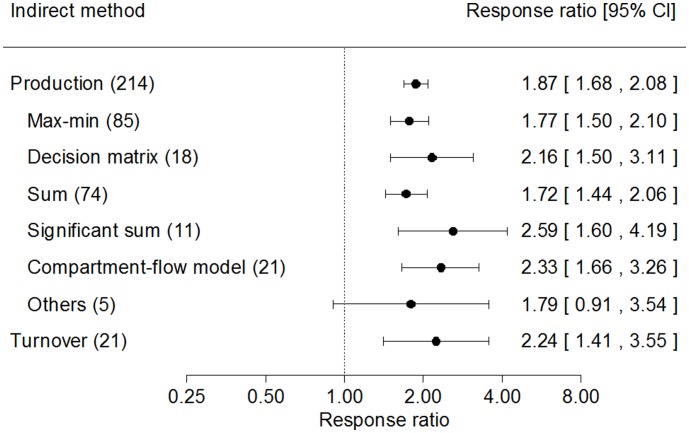
Response ratios for each indirect method.The number in parentheses represents the number of observations. The dot with error bars shows the mean effect size with the 95% confidence interval. The methods of ‘others’ refer to carbon and correlation methods.